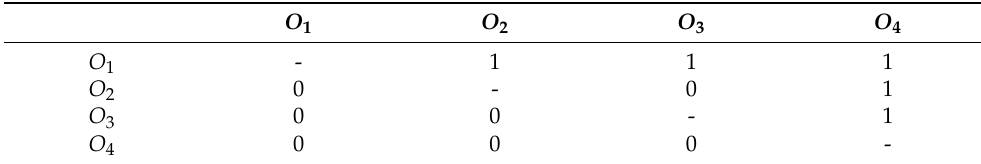
Table 26. The Boolean matrix (Ke and Chen,